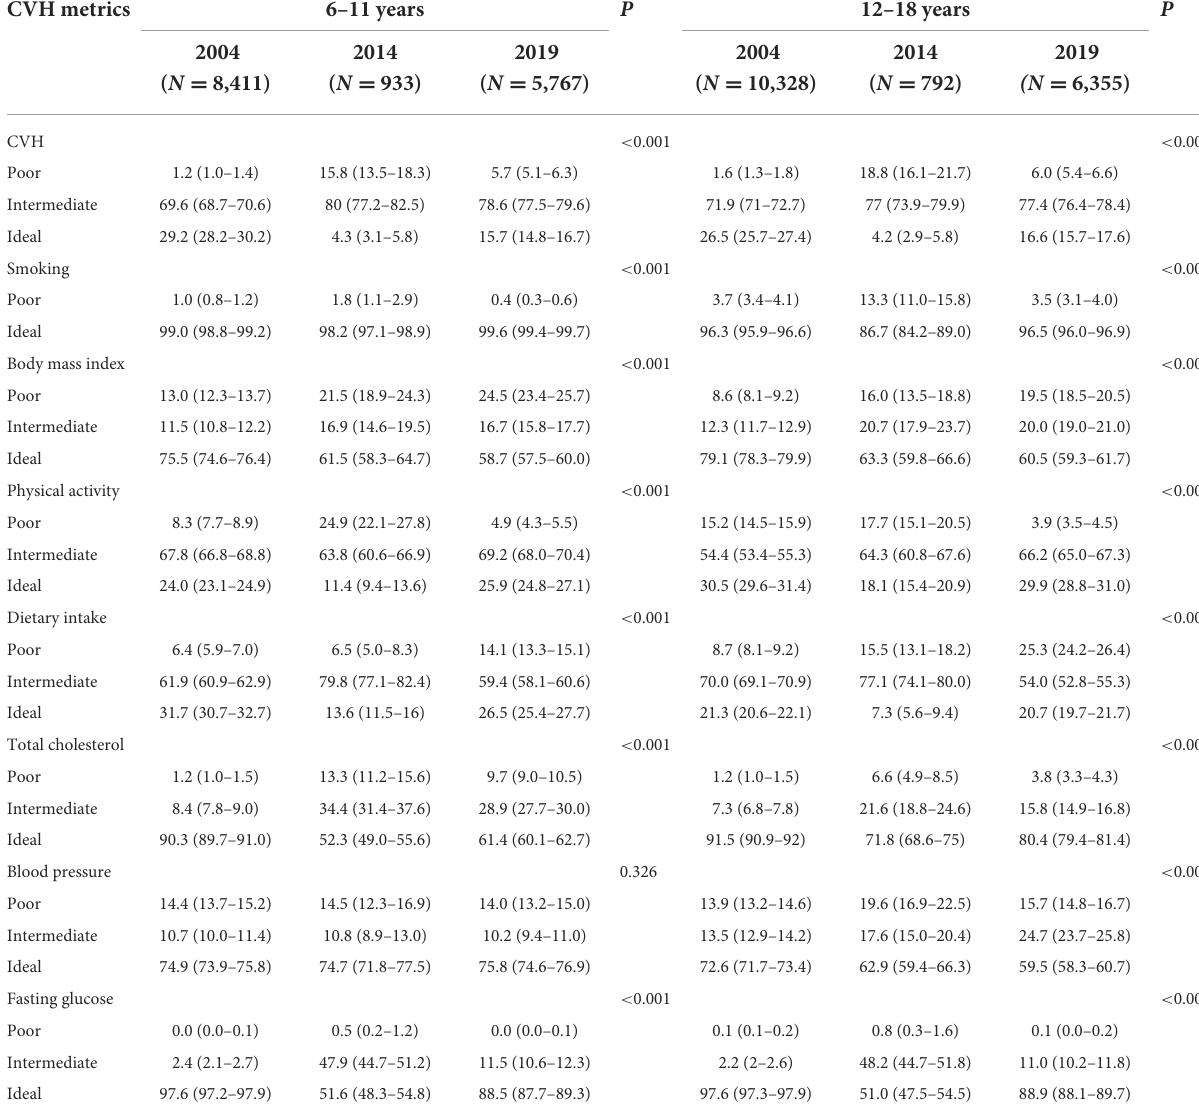
TABLE 6 Proportions (95% CI ) of poor, intermediate, and ideal cardiovascular metrics by age: